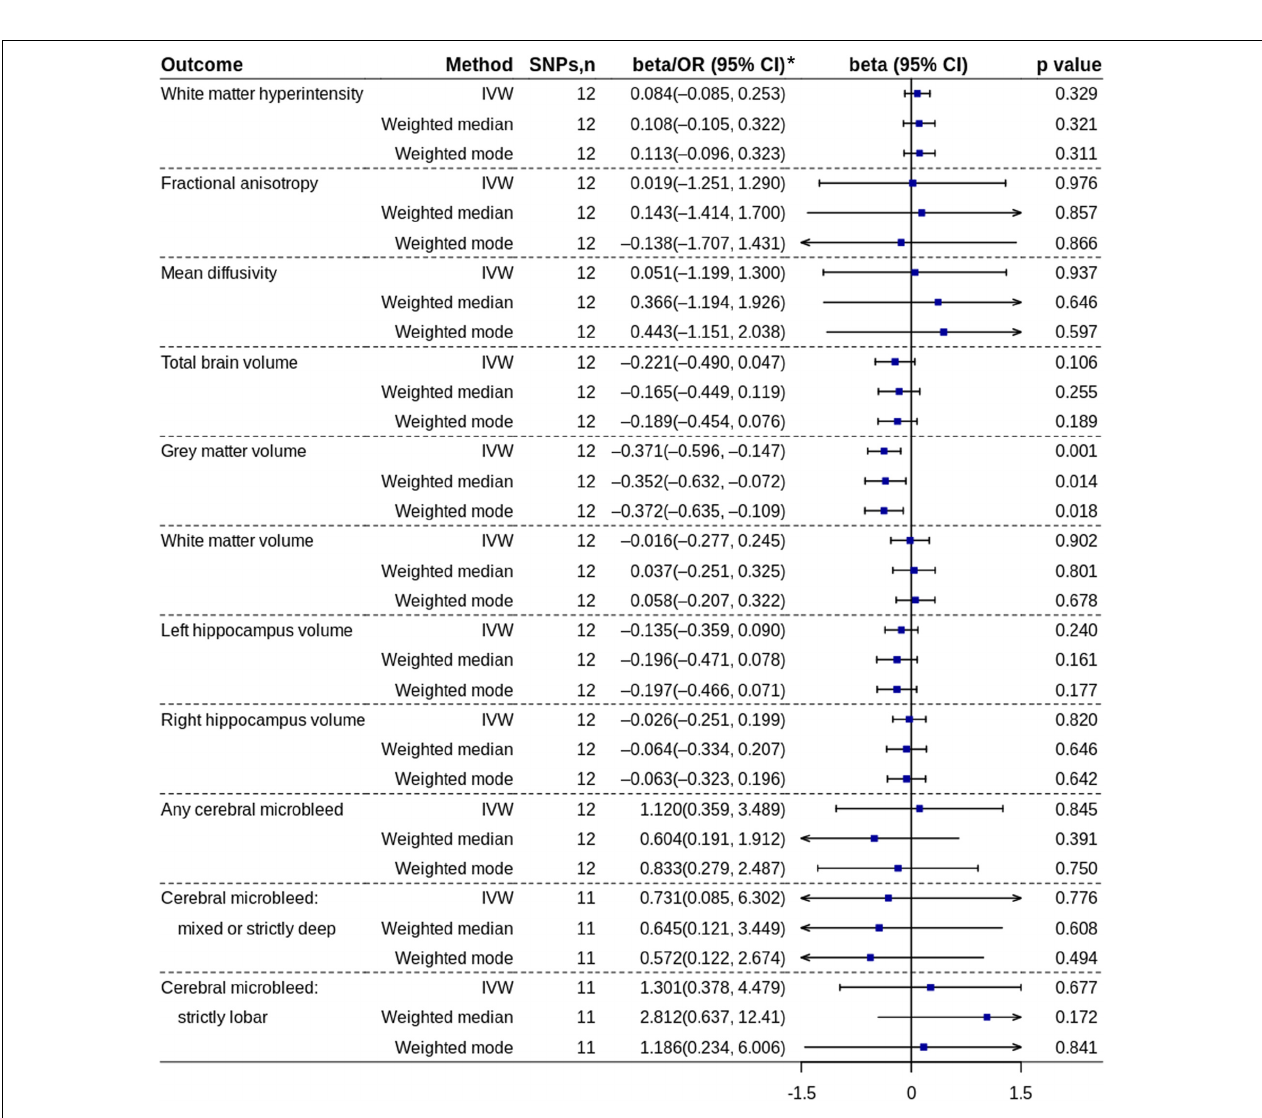
FIGURE 2 | Mendelian randomization analyses of coffee consumption (cups/day) on each outcome. *ORs with 95% CIs are presented for cerebral microbleed outcomes. IVW, inverse variance-weighted; OR, odds ratio; SNP, single nucleotide polymorphism.